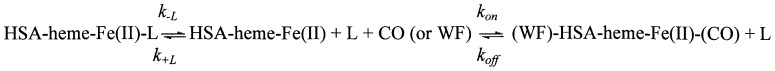
Scheme for the CO (and/or WF) binding to the endogenously hexa-coordinated HSA-heme-Fe(II)-L species.